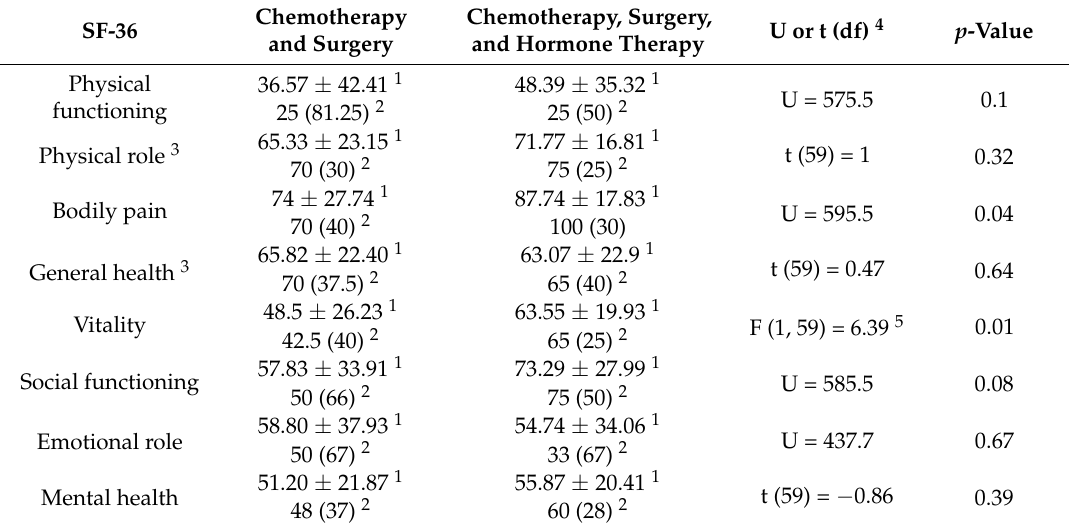
Table 8. Effects of treatment type on SF-36